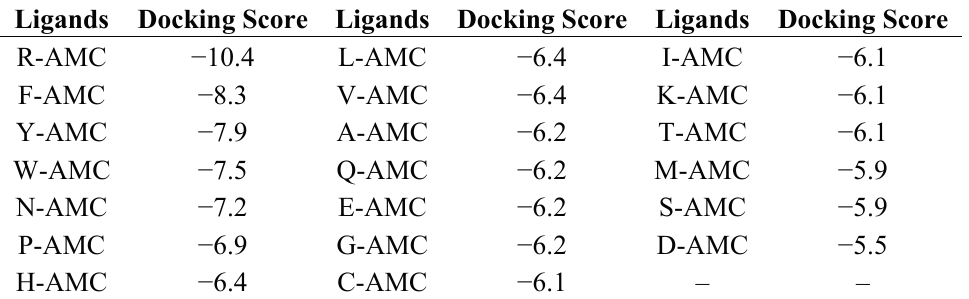
Table 2. The docking scores among the 20 peptides and zmCP1 (kcal·mol − 1 ). Ligands Docking